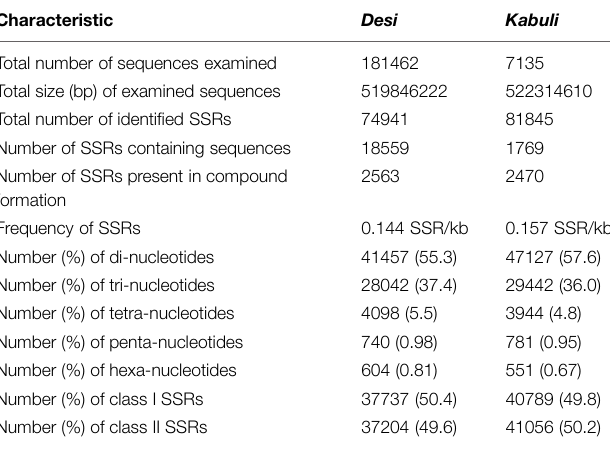
TABLE 1 | Summary of SSRs identified in desi and kabuli chickpea